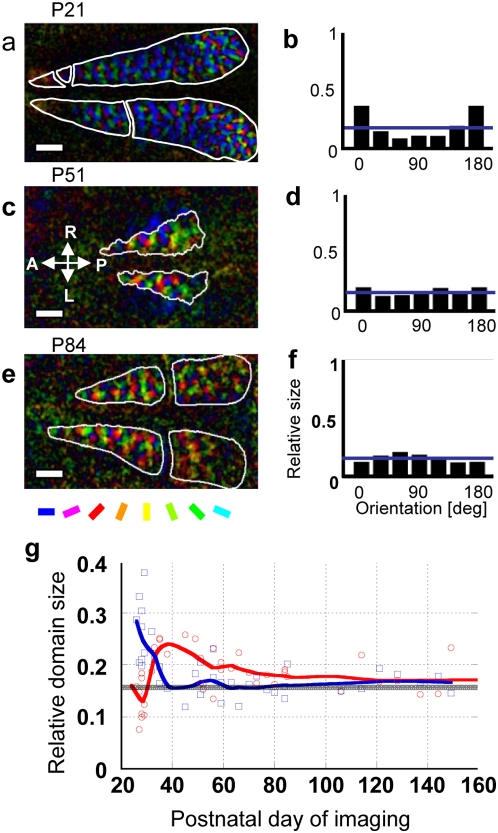
Orientation selectivity in normally reared kittens.Data are shown for postnatal days indicated. (a), (c) and (e): orientation polar maps. Color and brightness indicate preferred orientation and orientation selectivity. White curves delineate functionally defined area 17. Scale bars, 2 mm. Color code is placed below e. (b), (d) and (f): orientation histograms. Height of bins indicates the relative size of cortical domains preferentially responding to stimulus orientations. Horizontal lines indicate the relative size of iso-orientation domains for a uniform orientation representation. The same bin is doubly depicted at 0° and 180° for symmetric representation. Cortical coordinate placed on c: A, anterior; P, posterior; R, right; and L, left. (g): the relative size of cortical domains preferentially responding to vertical orientation (red dots) and horizontal orientation (blue dots) plotted against the postnatal day of optical imaging repeated in 23 normally reared kittens. Two curves were obtained using Stineman's smoothing procedure.